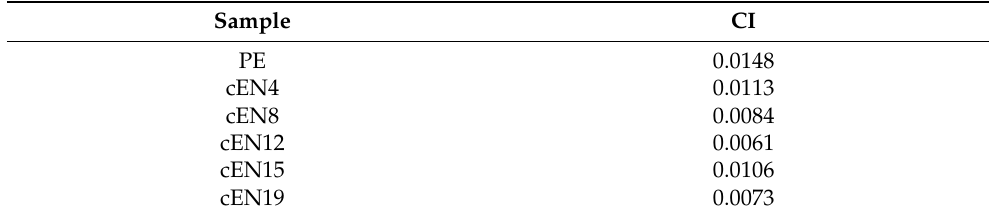
Figure 3. ATR-FTIR spectra for all the samples ( a ), and normalized spectra ranging between 2000 and 400 cm − 1 ( b ). The different carbonyl indexes are displayed in Table 6, where significant changes can be observed. In particular, the incorporation of norbornene into the polymeric chains seems to significantly decrease the CI. This apparent greater endurance against oxidation is discussed in the next section. Table 6. Carbonyl index for all the samples. Sample